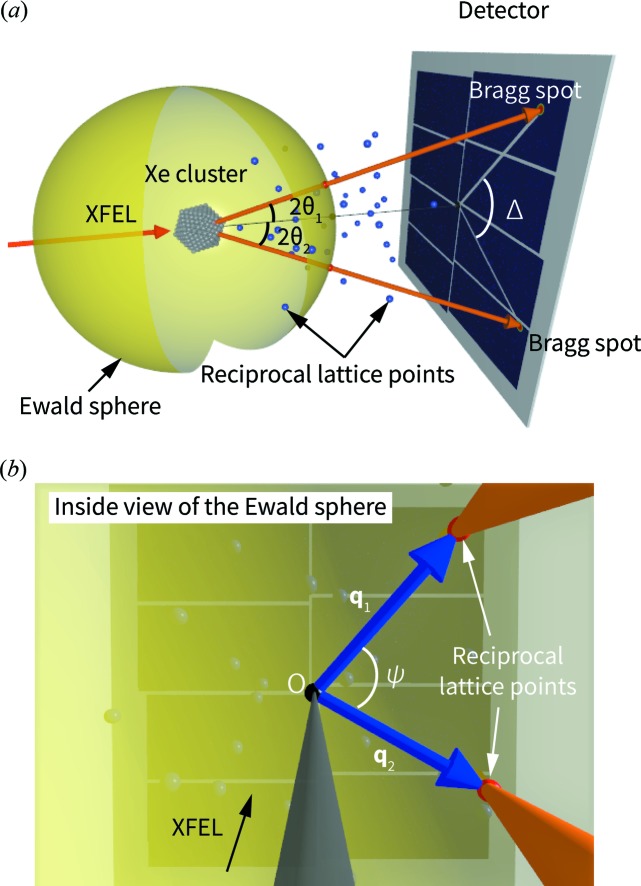
The geometry in reciprocal space together with the experimental configuration. (a) Ewald sphere (yellow) and reciprocal lattice points (navy blue and red) are depicted with the experimental configuration. θ1 and θ2 are Bragg angles and Δ is the azimuthal angular separation between the two Bragg spots. (b) Inside view of the Ewald sphere. ψ is defined as the angle between the two corresponding momentum-transfer vectors: q
1 and q
2.